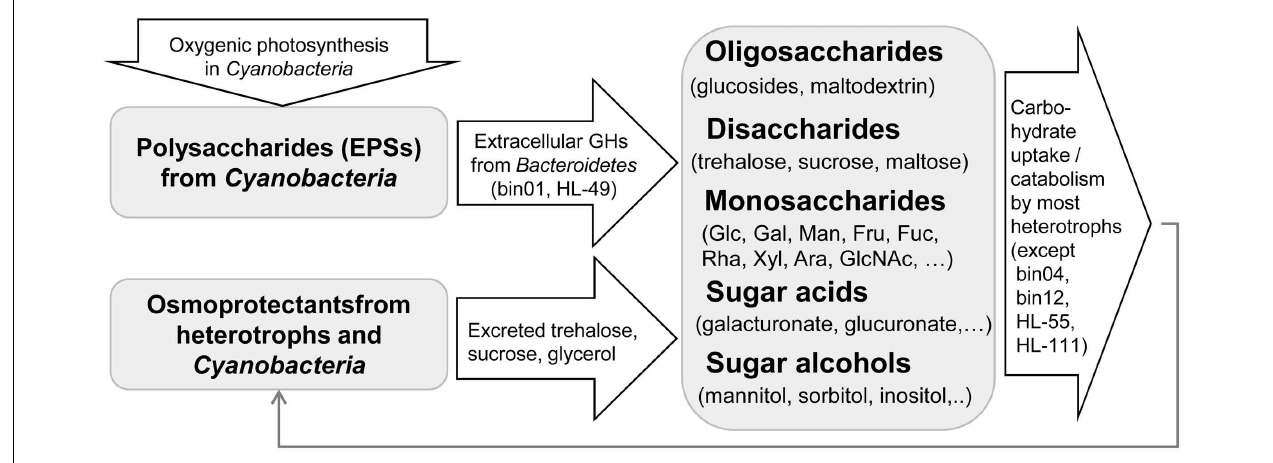
FIGURE 7 | Proposed scheme for carbon flow in the